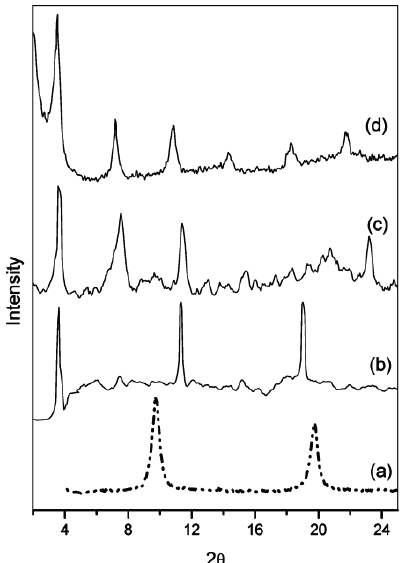
Figure 8. X-ray diffraction patterns of (a) MgAl – LDH–NO (c) MgAl – LDH–diclofenac; and (d) MgAl – LDH–indomethacin. Reprinted with permission from [65] (Copyright 2005 American Chemical